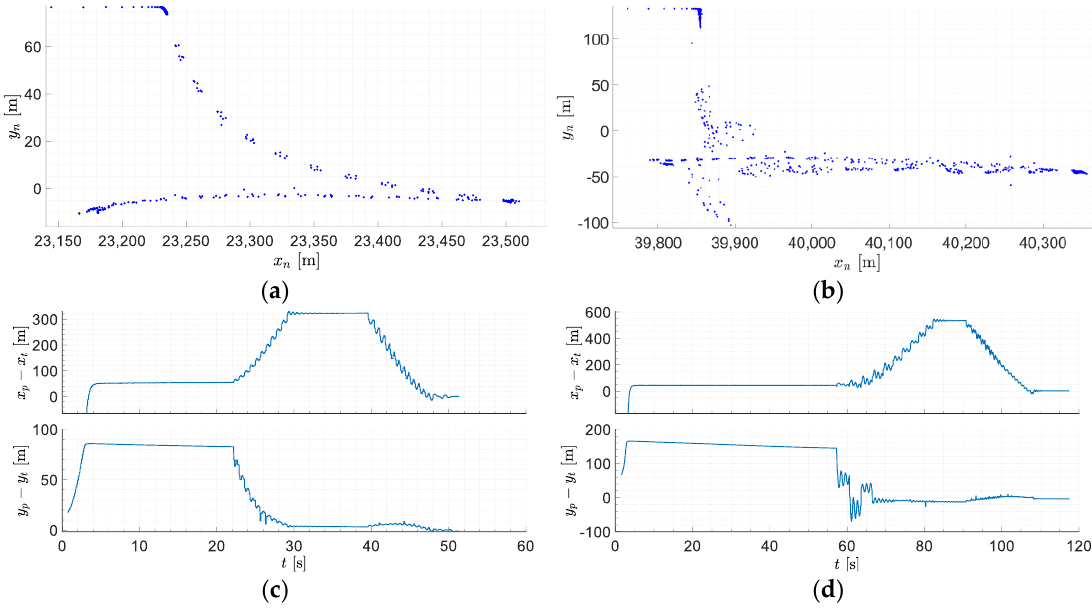
Figure 10. Impact point locations in the target plane (terminal phase) for ( a ) Θ 0 = 20 ◦ ( b ) Θ 0 = 50 ◦ and range / cross-range errors time history ( c ) Θ 0 = 20 ◦ ( d ) Θ 0 = 50 ◦ Figure 10 . Impact point locations in the target plane (terminal phase) for (a) 𝛩 0 = 20° (b) 𝛩 0 = 50° and range/cross-range errors time history (c) 𝛩 0 = 20° (d) 𝛩 0 = 50°